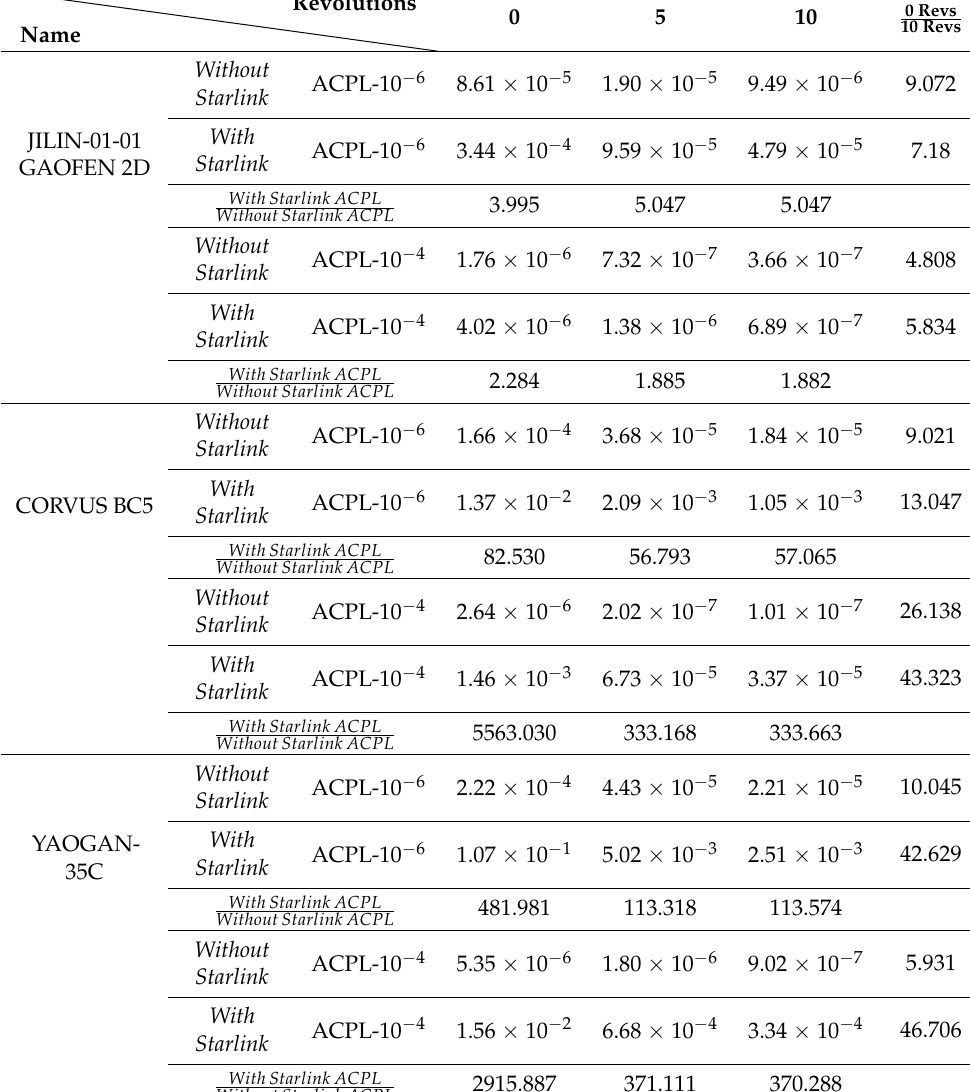
Table 5. Comparison of PMF data in Figure